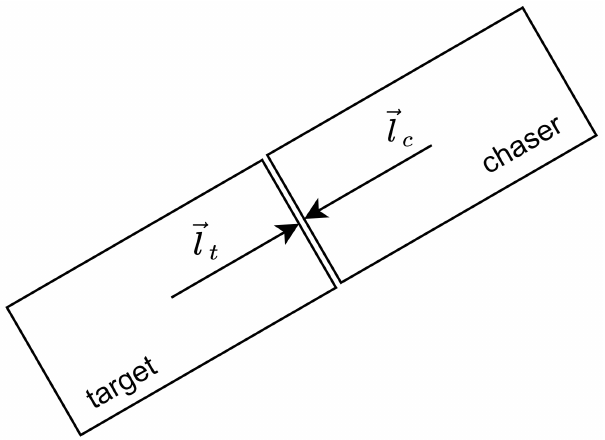
Figure 3. Final docking configuration where the chaser’s docking port matches the target’s docking port and the chaser’s final position and attitude are determined from the target’s final